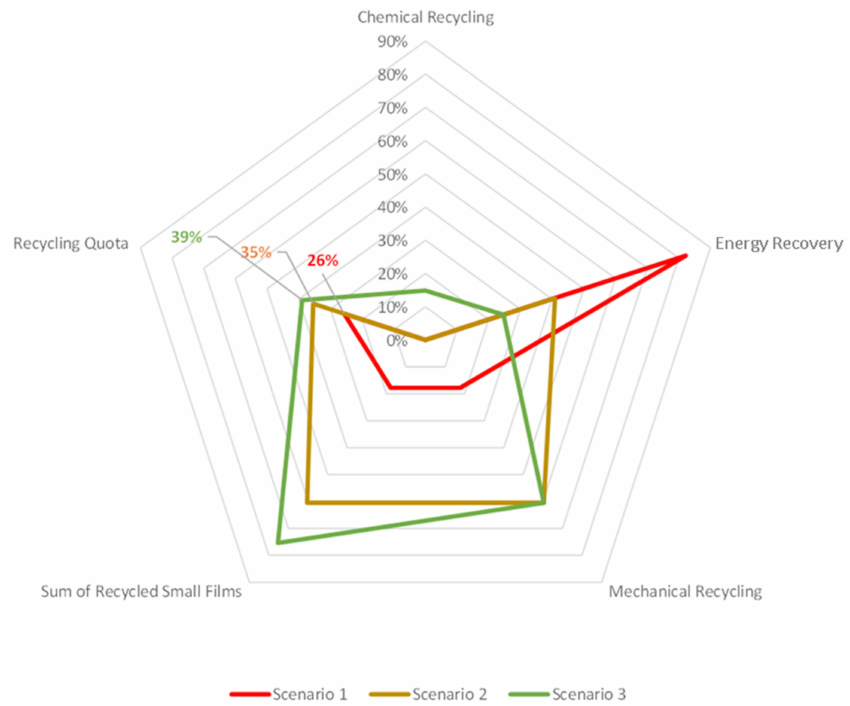
Figure 11. Radar diagram comparing the three evaluated scenarios based on the characteristic metrics: Energy recovery, Mechanical recycling, sum of recycled films, recycling quota and chemical